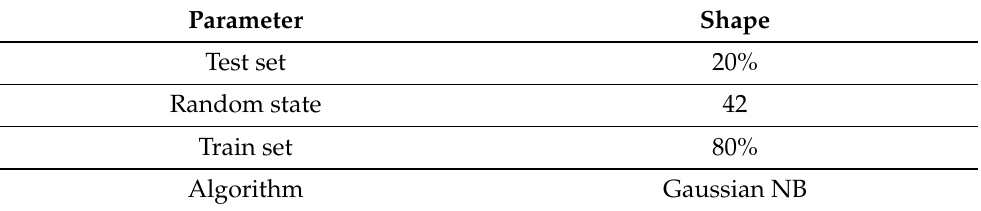
Table 6. The Specifications Model of NB.